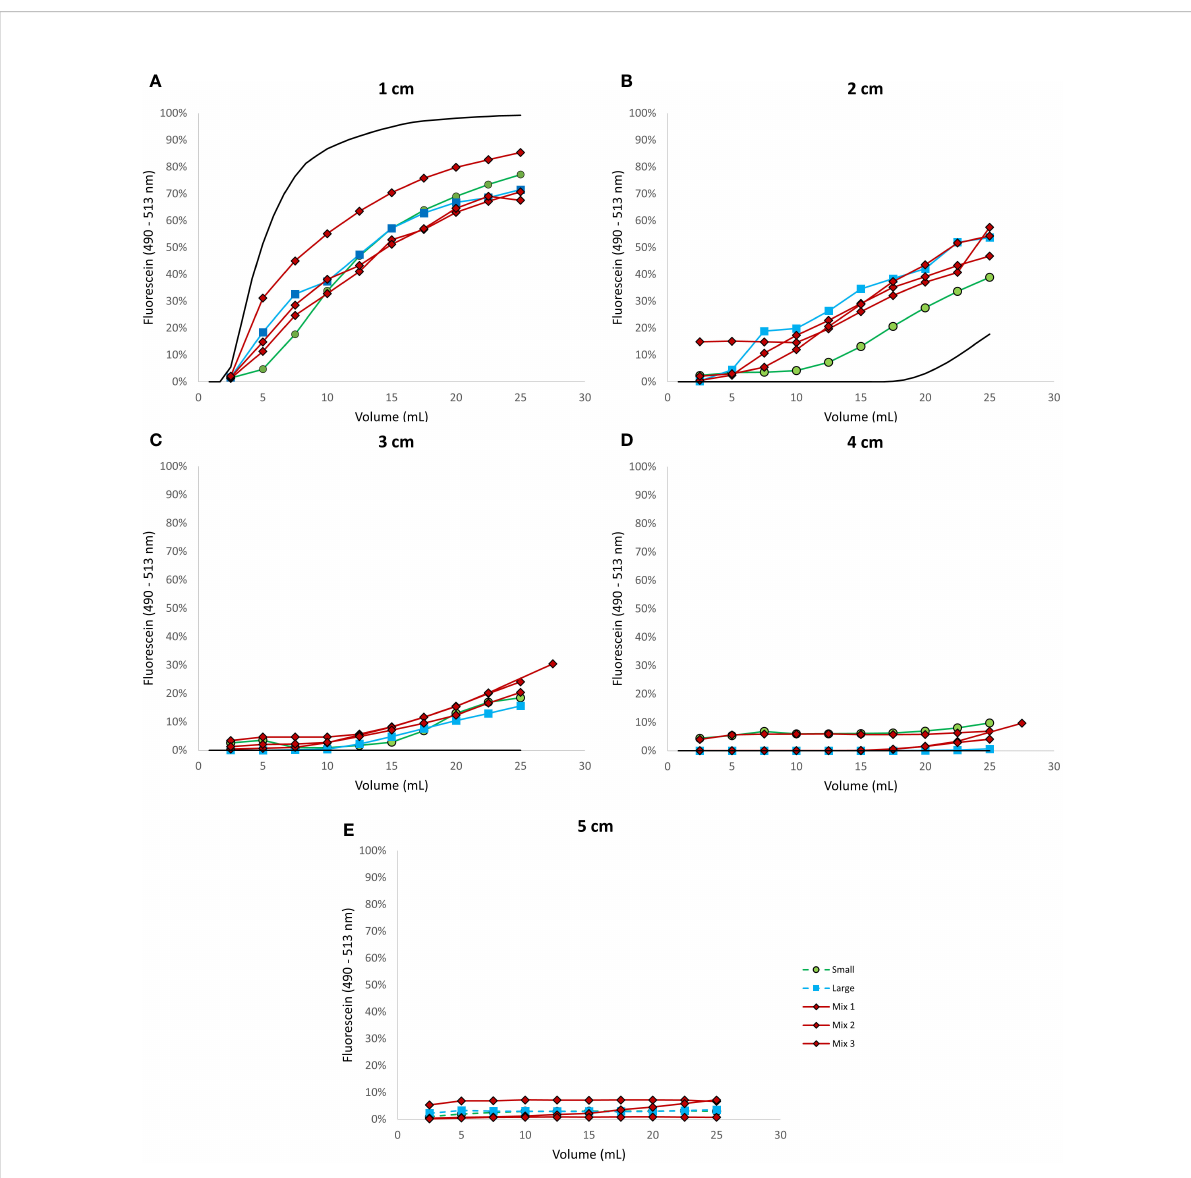
FIGURE 3 The proportion of fl uorescein (%) in the samples with reference to the fl uorescein in the overlying water as a function of the extracted volume of porewater through Rhizons for sediments with different grain sizes. This experiment was conducted in the lab. The large and small sized sediment grains were sieved through mesh with sieve size of 2000 µm and 1000 µm respectively and were mixed together in mix1, mix2 and mix 3 categories. The pro fi les represent porewater extraction when the single opening in the PLA/ABS case is at (A) 1 cm, (B) 2 cm, (C) 3 cm, (D) 4 cm and (E) 5 cm below the sediment surface. The corresponding theoretical model is plotted in required